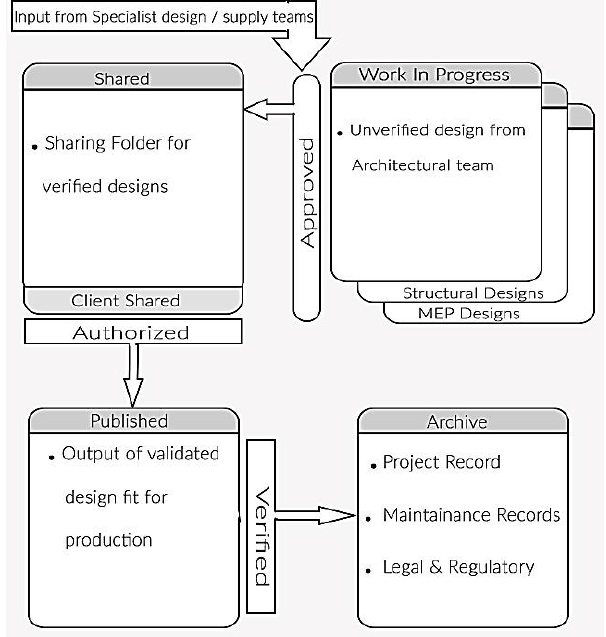
Figure 1. Schematics of a common data environment based on PAS 1192 ‐ 2 (Source: [2]).